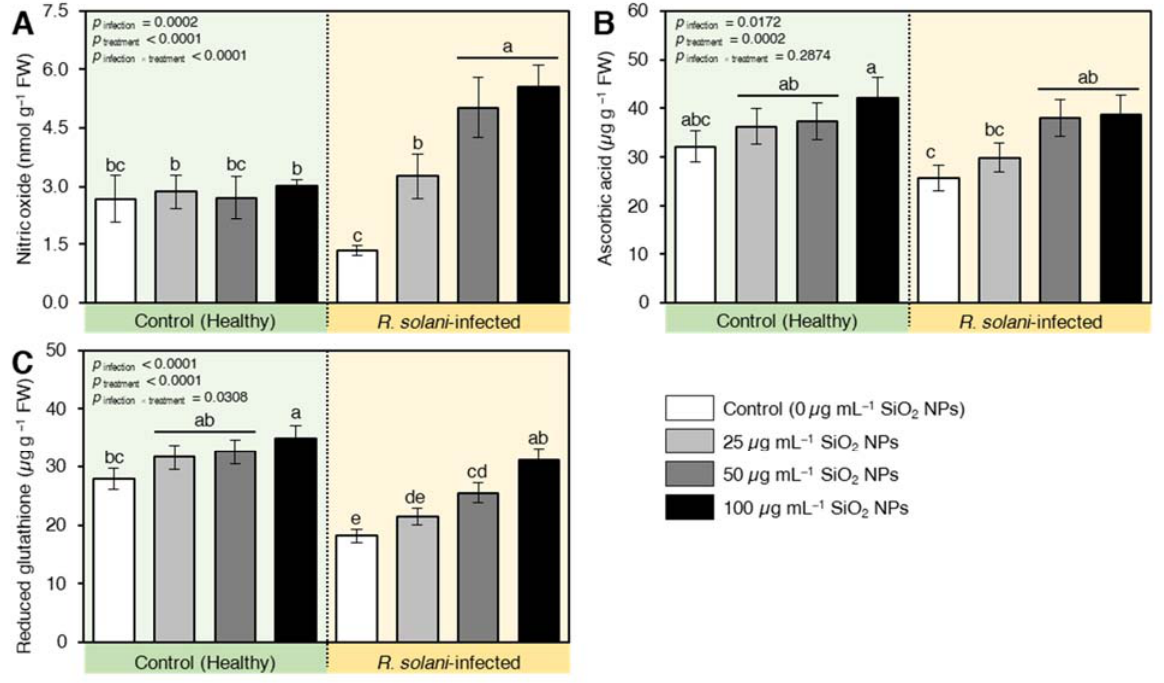
Figure 9. Effect of silicon dioxide nanoparticles (SiO 2 NPs) on the non-enzymatic antioxidant machinery of R. solani -infected seedlings. ( A ) Nitric oxide (nmol g − 1 FW), ( B ) Ascorbic acid ( µ g g − 1 FW), and ( C ) Reduced glutathione ( µ g g − 1 FW). Data presented are means ± standard deviation (mean ± SD) of five biological replicates. Different letters indicate statistically significant differences among treatments, while the same letters signify no significant differences between them according to Tukey’s honestly significant difference test ( p < 0.05).